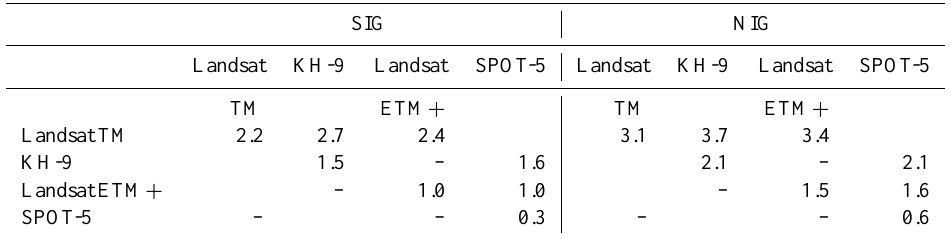
Table 2. Uncertainty of glacier delineation